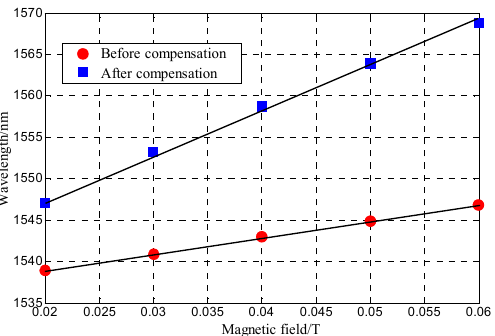
Figure 9. FBG wavelength shift variation versus temperature.